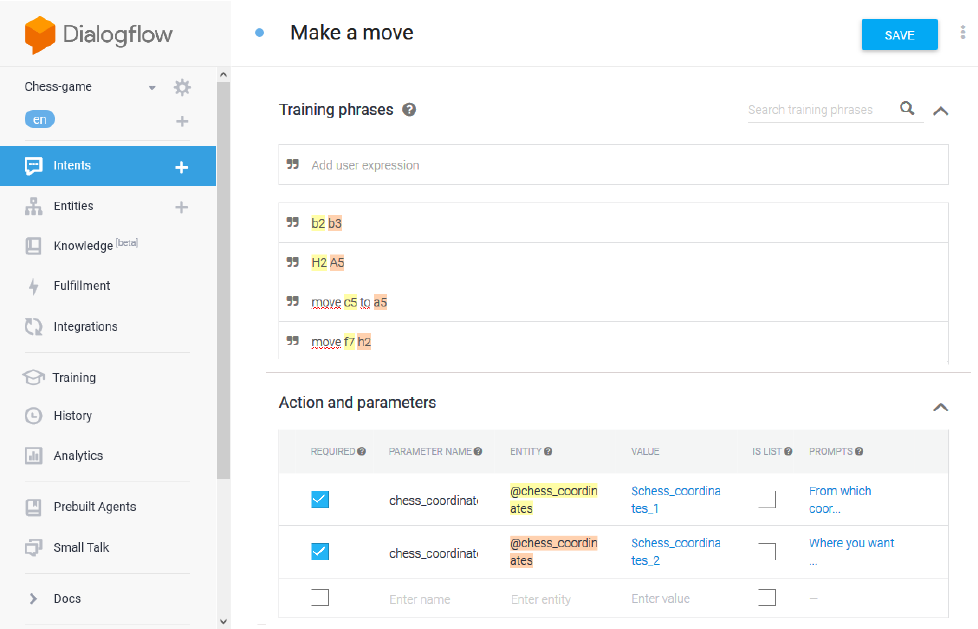
Figure 2. Make a move intent from Mr. Chess Dialogflow console.